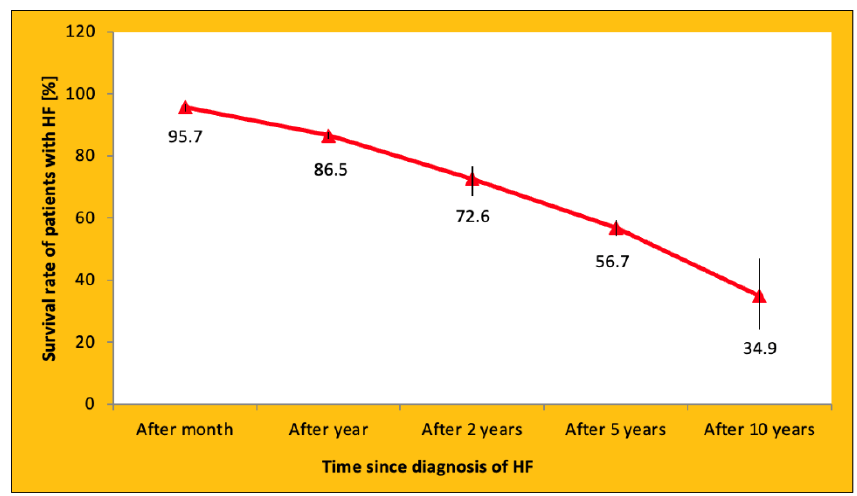
Figure 1. Survival of patients with HF. Based on information from [9]. HF — heart failure . Thus, HF significantly worsens the prognosis and shortens the survival of patients.